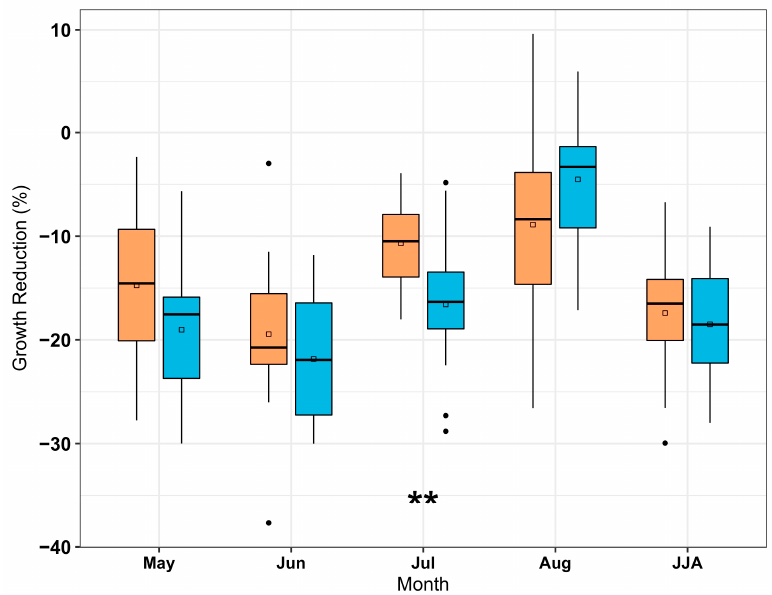
Figure 3. Percentage of standardized radial growth reduction of co-occurring Carya ovata (orange) and Quercus alba (blue) chronologies during drought (SPEI ≤ − 1.5) of individual months and June- July–August (JJA) of current growing season at 15 study sites. Asterisk indicates that means of growth reduction between C. ovata and Q. alba are significantly different at a 0.01 level.